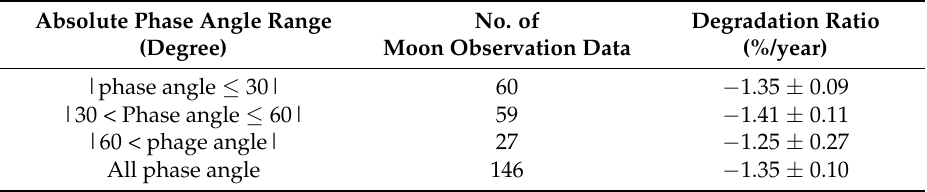
Table A2. Difference in degradation ratio of COMS visible channel due to absolute phase angle range.